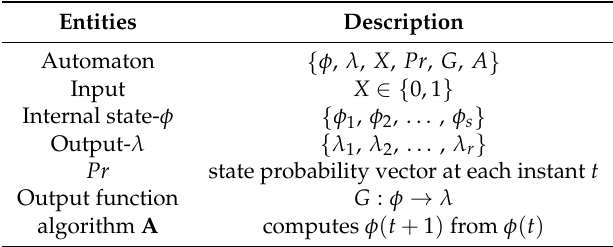
Table 1. Entities and